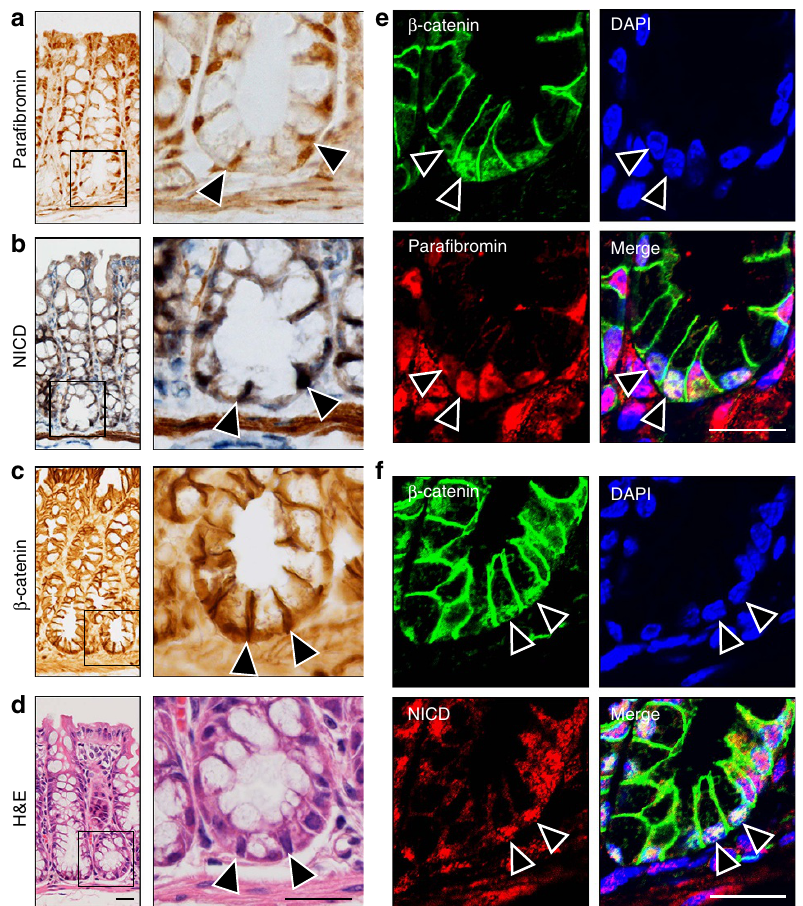
Figure 6 | Co-expression of proteins in intestinal crypts. ( a – d ) Parafibromin ( a ), NICD ( b ) and b -catenin ( c ) immunohistochemistry of the mouse colon. H&E staining of the serially sectioned sample is shown in d . The right panels show higher-magnification images of crypt bases. Arrowheads indicate the positive nuclear staining of each antibody. Scale bars, 20 m m. ( e , f ) Immunohistochemical analysis of b -catenin and parafibromin expression ( e ) and b -catenin and NICD expression ( f ) in the bottom region of colonic crypts. Nuclei were stained in blue (DAPI). Arrowheads indicate the cells showing co-localization of parafibromin, b -catenin and NICD. Scale bars, 20 m